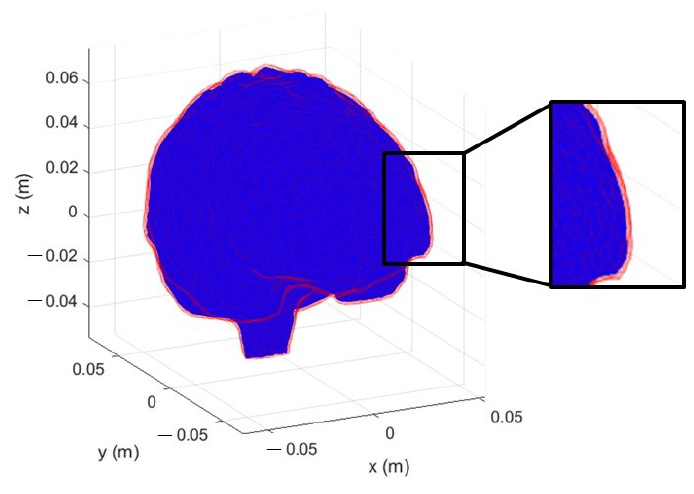
Figure 15. Grey matter volume variation: starting volume in blue; layer of variation in